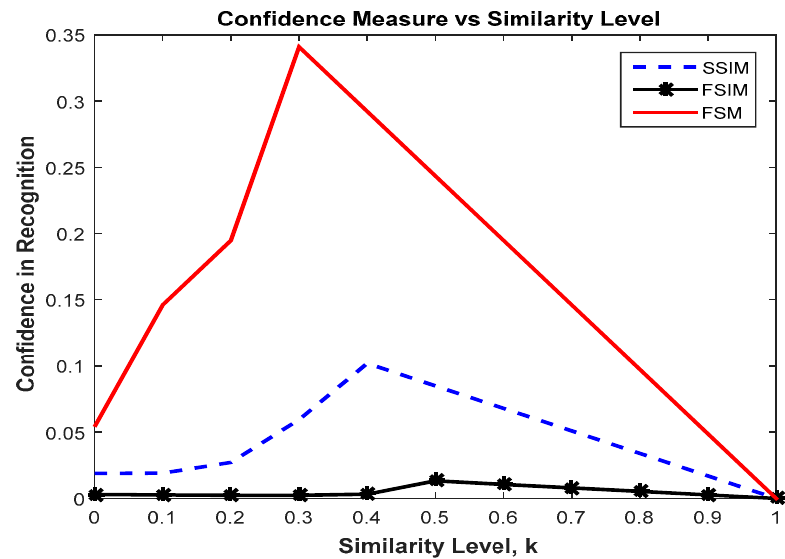
Figure 13. Recognition confidence for similarity measures SSIM, FSIM and FSM using person No. 8 (pose 10) in the AT&T database.